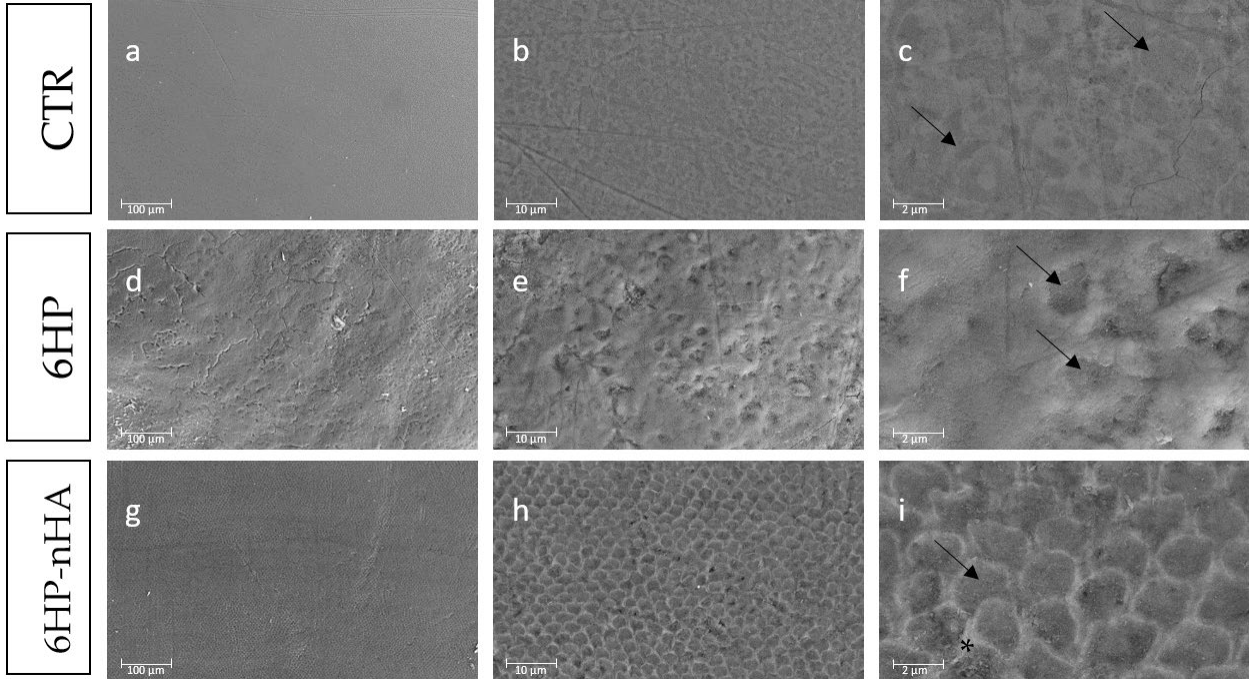
Figure 2. Scanning electron micrographs of a representative Control Group (CTR), 6% hydrogen peroxide (6HP) and 6% hydrogen peroxide enriched with nano-hydroxyapatite (6HP-nHA) at 400× (a,d,g), 2000× (b,e,h) and 8000× (c,f,i) original magnification. CTR: Micrographs ( a ) and ( b ) display the typical aspect of sound enamel morphology, with the aprismatic layer. In ( c ), the rods-like structure is slight visible (black arrows). 6HP: Micrograph ( d ) displays a partially sound enamel morphology with enamel-like crystal structure. In ( e ) loss of enamel surface integrity structure and an irregular surface are shown. Micrograph ( f ) shows the slight dissolution of prisms with partial destruction of the rods and interrods structure (black arrows), presenting a more irregular surface. 6HP-nHA: Micrograph ( g ) displays a sound enamel morphology with enamel-like crystals. In ( h ) and ( i ) the structure of the enamel prisms is emphasized since the rods and interrods are clearly distinguishable (black arrow and asterisk, respectively).